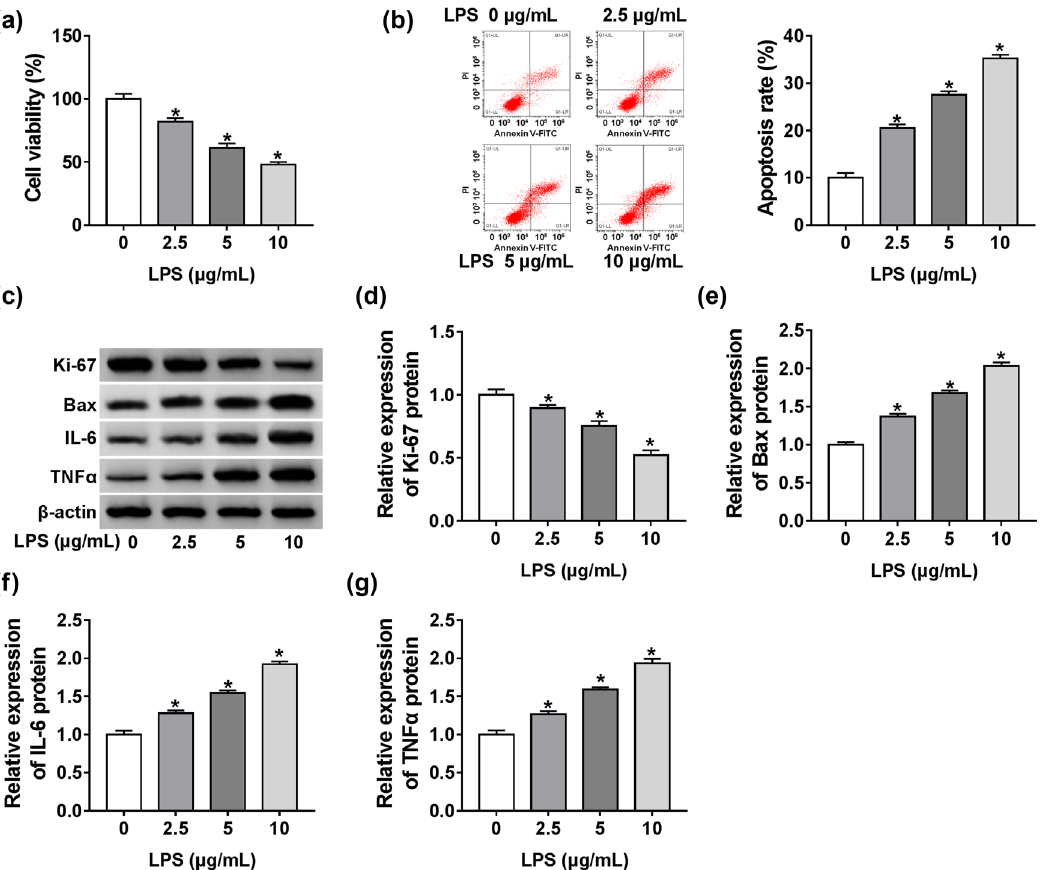
Figure 1: LPS weakened cell viability and promoted apoptosis and in fl ammation in HK - 2 cells. HK - 2 cells were exposed to various con - centrations ( 0, 2.5, 5, and 10 µg/mL ) of LPS for 48 h. ( a ) CCK - 8 assay for cell viability. ( b ) Flow cytometry for cell apoptosis. ( c – g ) Western blot for Ki - 67, Bax, IL - 6, and TNF α levels. * P <